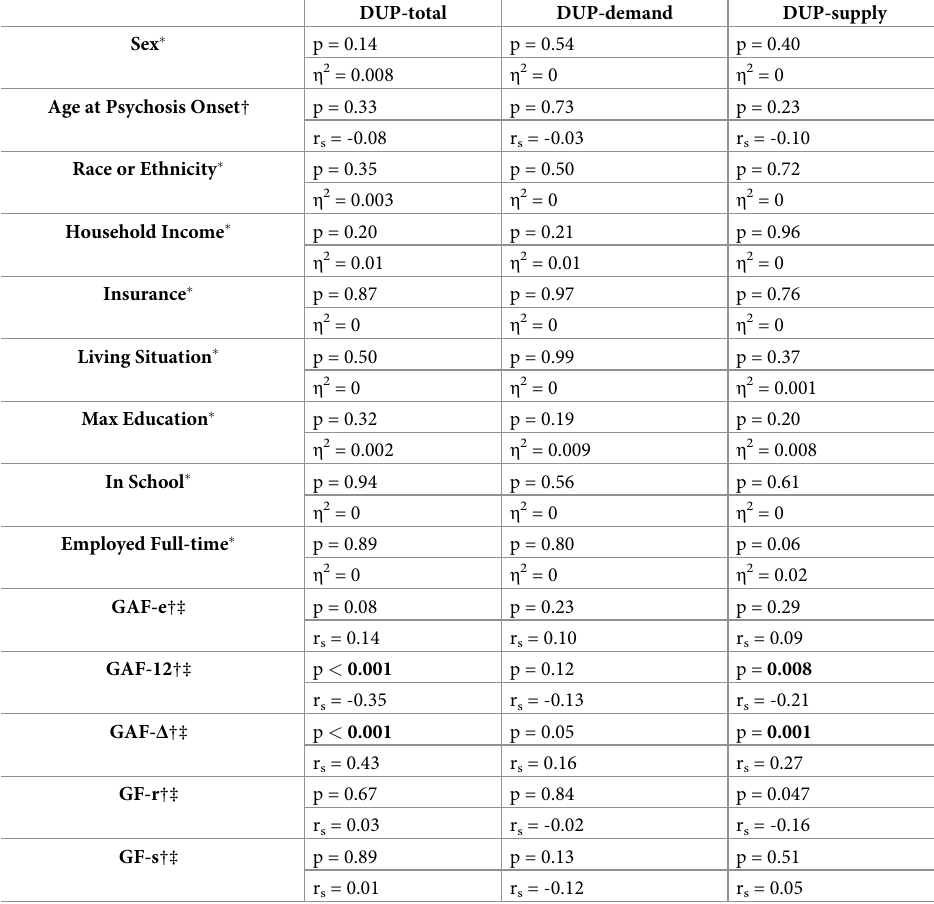
Table 3. Association and effect size testing of patient factors with global delay